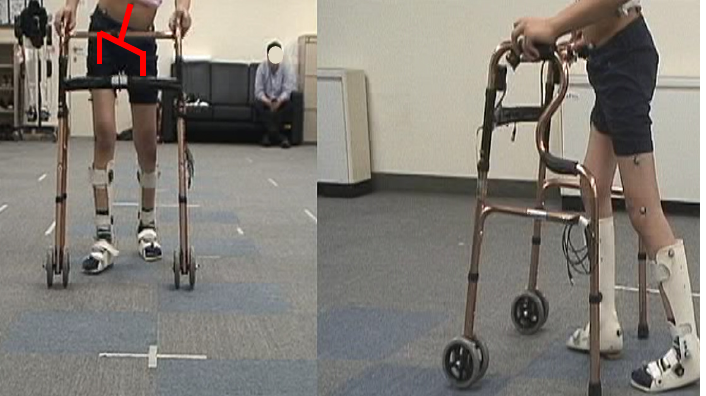
Figure 9. Gait analysis of a patient with spina bifida wearing Ankle Foot Orthosis (AFO) and using a walker.